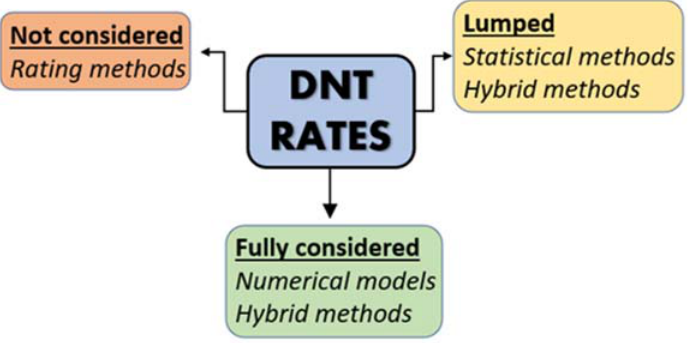
Figure 3. DNT rates as employed in the different vulnerability assessment